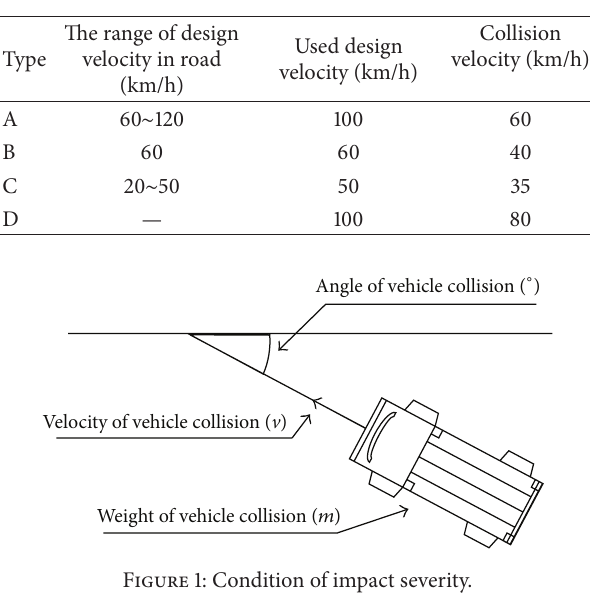
Table 1: Relationship between design and collision velocities.